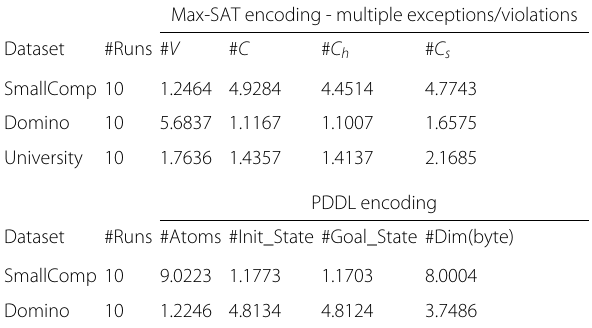
Table 5 Datasets in our benchmark: multiple exceptions and